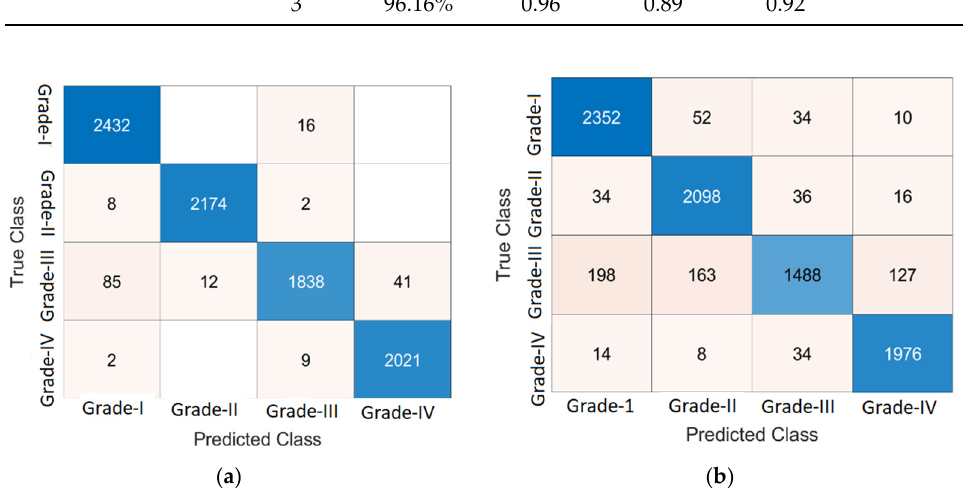
Figure 8. Classification of DR lesions. ( a ) KNN of the optimizable kernel, ( b ) NN of medium neural network.